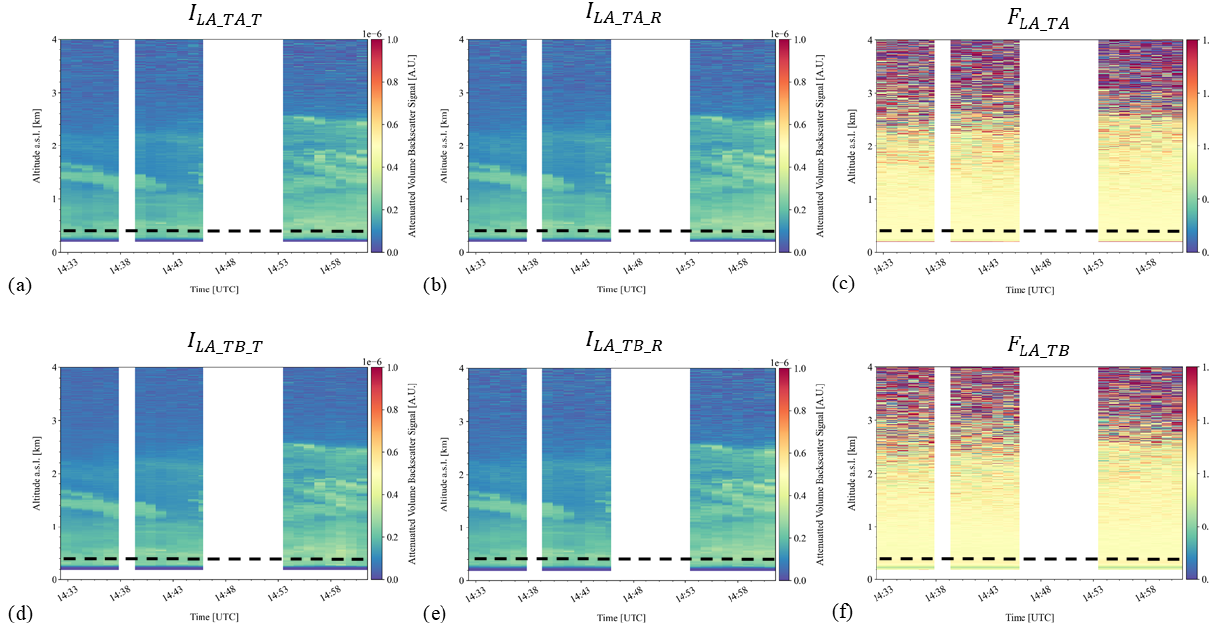
Figure 13. Lidar measurements at 1064nm, acquired at Athens, Greece, on 15 June 2021, at 14:33–15:02UTC. The viewing angle is 80 ◦ off-zenith. The height in the plots denotes the altitude and not the range of the measurements, and it is provided above sea level (a.s.l.). (a) I LA_TA_ T and (b) I LA_TA_ R are the attenuated backscatter signals from laser A measured at the detection unit of telescope A. (d) I LA_TB_ T and (e) I LA_TB_ R are the attenuated backscatter signals from laser A measured at the detection unit of telescope B. The corresponding orientation flags are shown in (c) F LA_TA and (f) F LA_TB . The dotted black line shows the full-overlap height of the signals, at 200m above the ground (i.e., 400ma.s.l.). The gaps in the quicklooks contain cloudy profiles which are screened out.